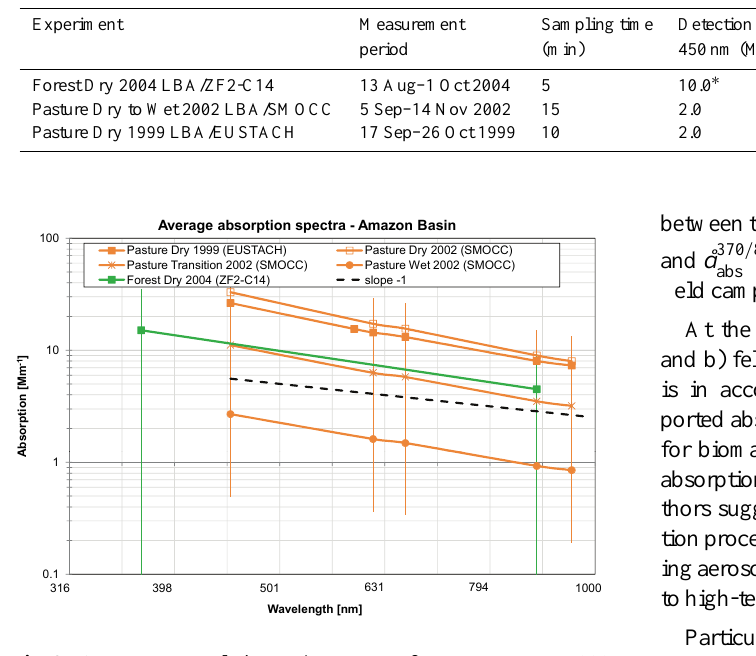
Fig. 3. Average aerosol absorption spectra for: Pasture Dry 1999 (EUSTACH) – comprising 4265 spectra; Pasture Dry to Wet 2002 (SMOCC) – comprising 5296 spectra; Forest Dry 2004 (ZF2-C14) – comprising 7927 spectra. Error bars represent statistical standard deviations. Also shown is a spectrum with a slope of − 1, character- istic of soot aerosol (black dashed